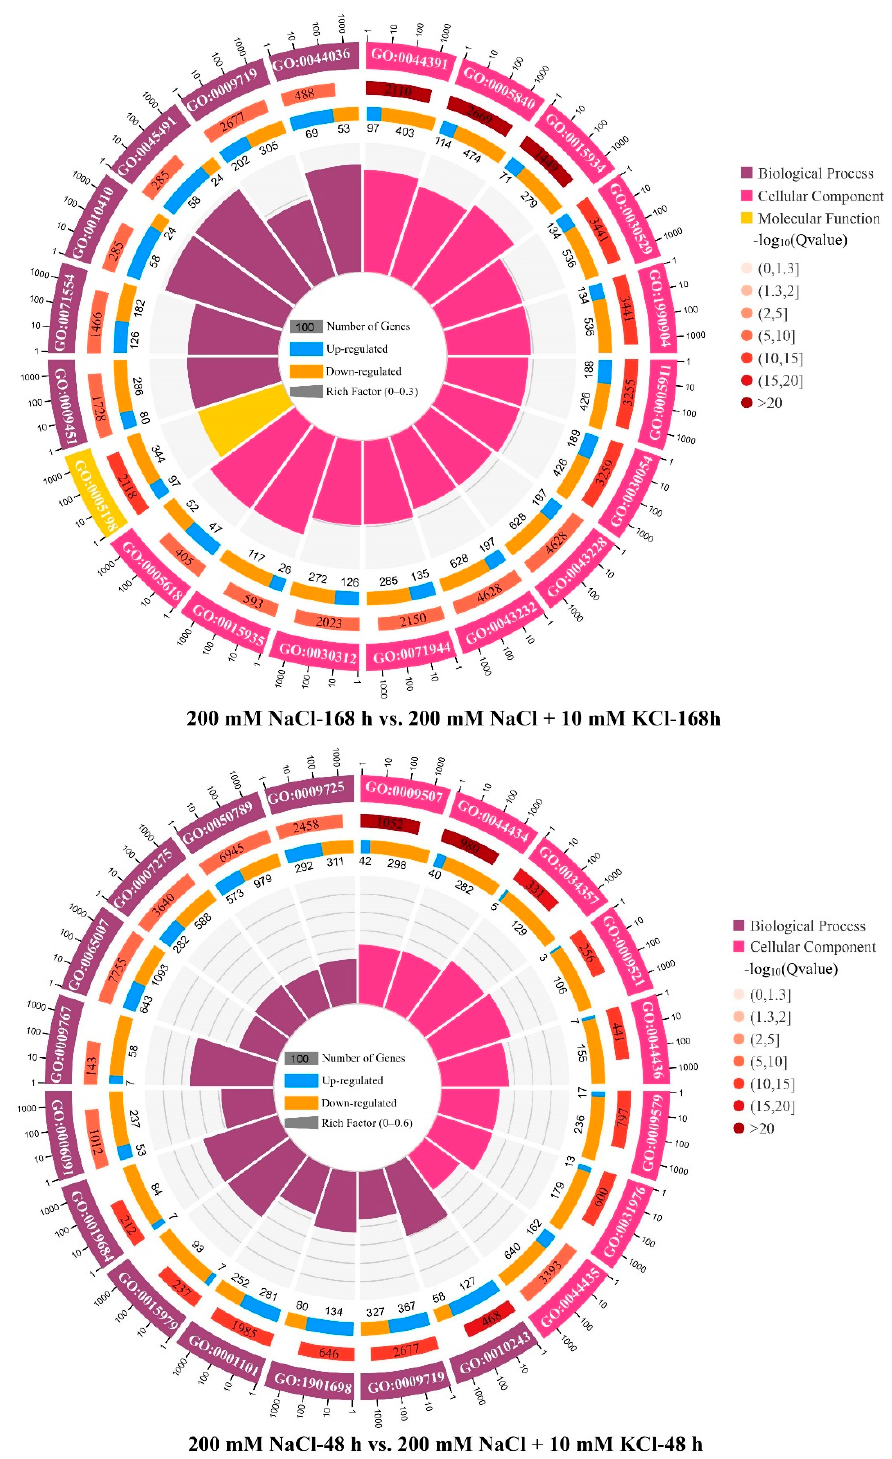
Figure 2. Top 20 GO enrichment (The first and outer circle: the top 20 GO terms are enriched, outside the circle is the scale of the number of genes. Different colors represent different ontologies. The second circle: the number of the GO term in the background gene and the Q value. The darker the color, the smaller the Q value. The longer the bars, the more genes they contain. The dark color represents the proportion of upregulated genes, and the light color represents the proportion of downregulated genes. The specific value is displayed below. The fourth and inner circle: the ratio of each GO term Rich Factor value (the number of differential genes in this GO term divided by all numbers), background grid lines; each grid represents 0.1). Table 4. Changes in the expression of K + channel- and transporter-related genes in the roots of T . ramosissima by exogenous potassium application under NaCl stress.